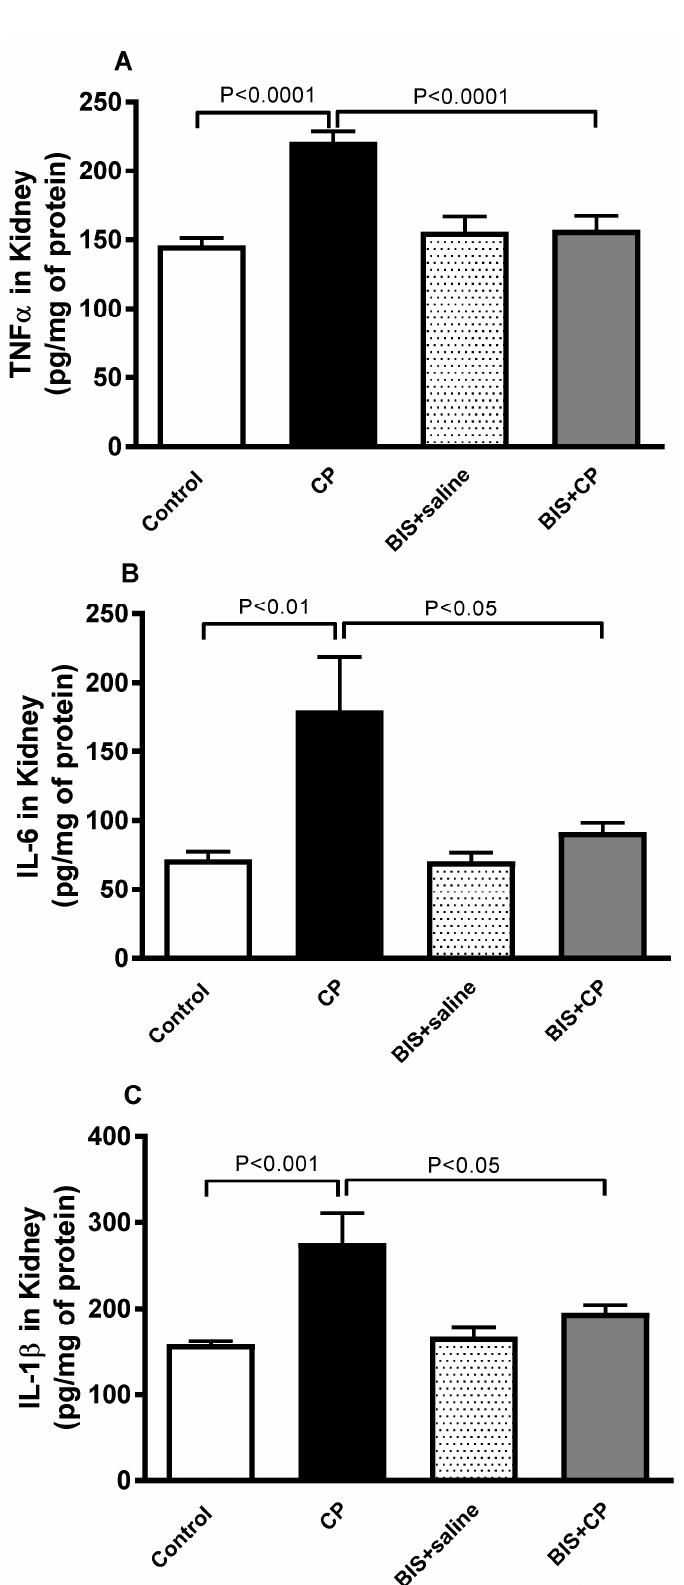
Figure 5. The renal concentrations of tumor necrosis factor-alpha (TNF α ( A )), interleukin (IL)-6 ( B ), and IL-1 β ( C ) in mice treated orally with either sunflower oil (control) or bisabolol (BIS, 25 mg/kg) with or without cisplatin (CP, 20 mg/kg) given intraperitoneally (n = 7–8). Mean ± SEM. Statistical analysis by ANOVA 1 followed by Holm–Sidak’s test.